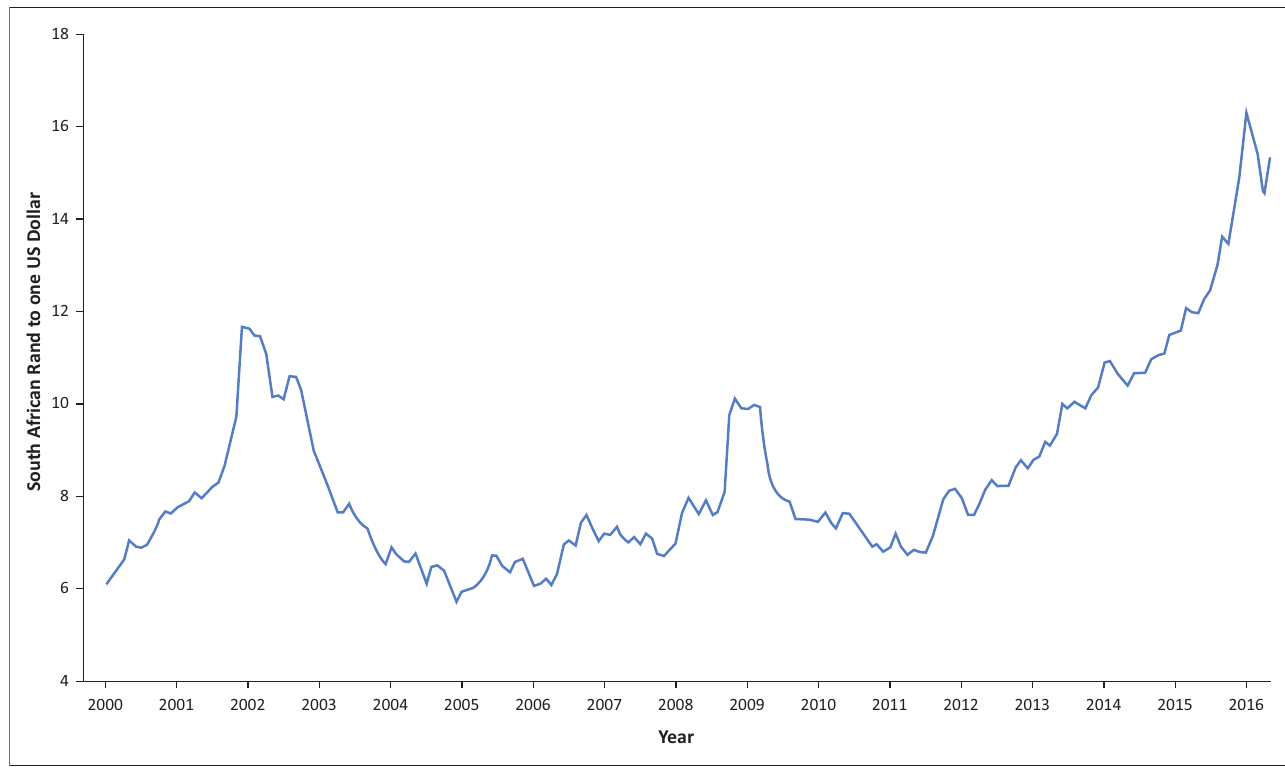
FIGURE 16: Rand/US Dollar exchange rate